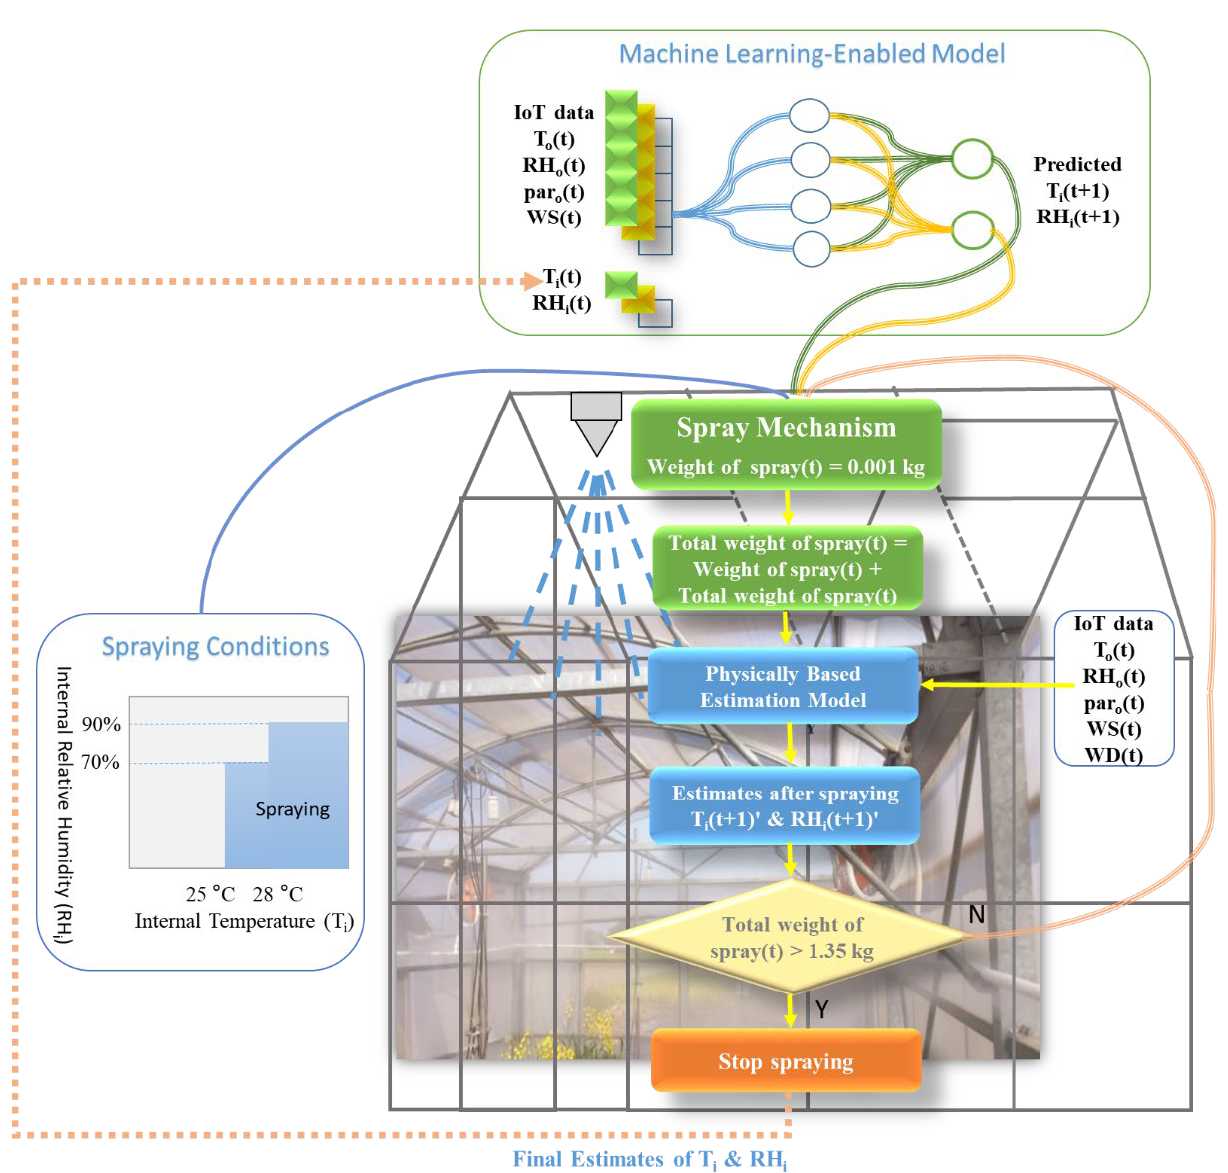
Figure 4. Spray-simulation flow chart of the SMCS that integrates the SD model, the BPNN prediction model, the physically based estimation model, and the spray mechanism.